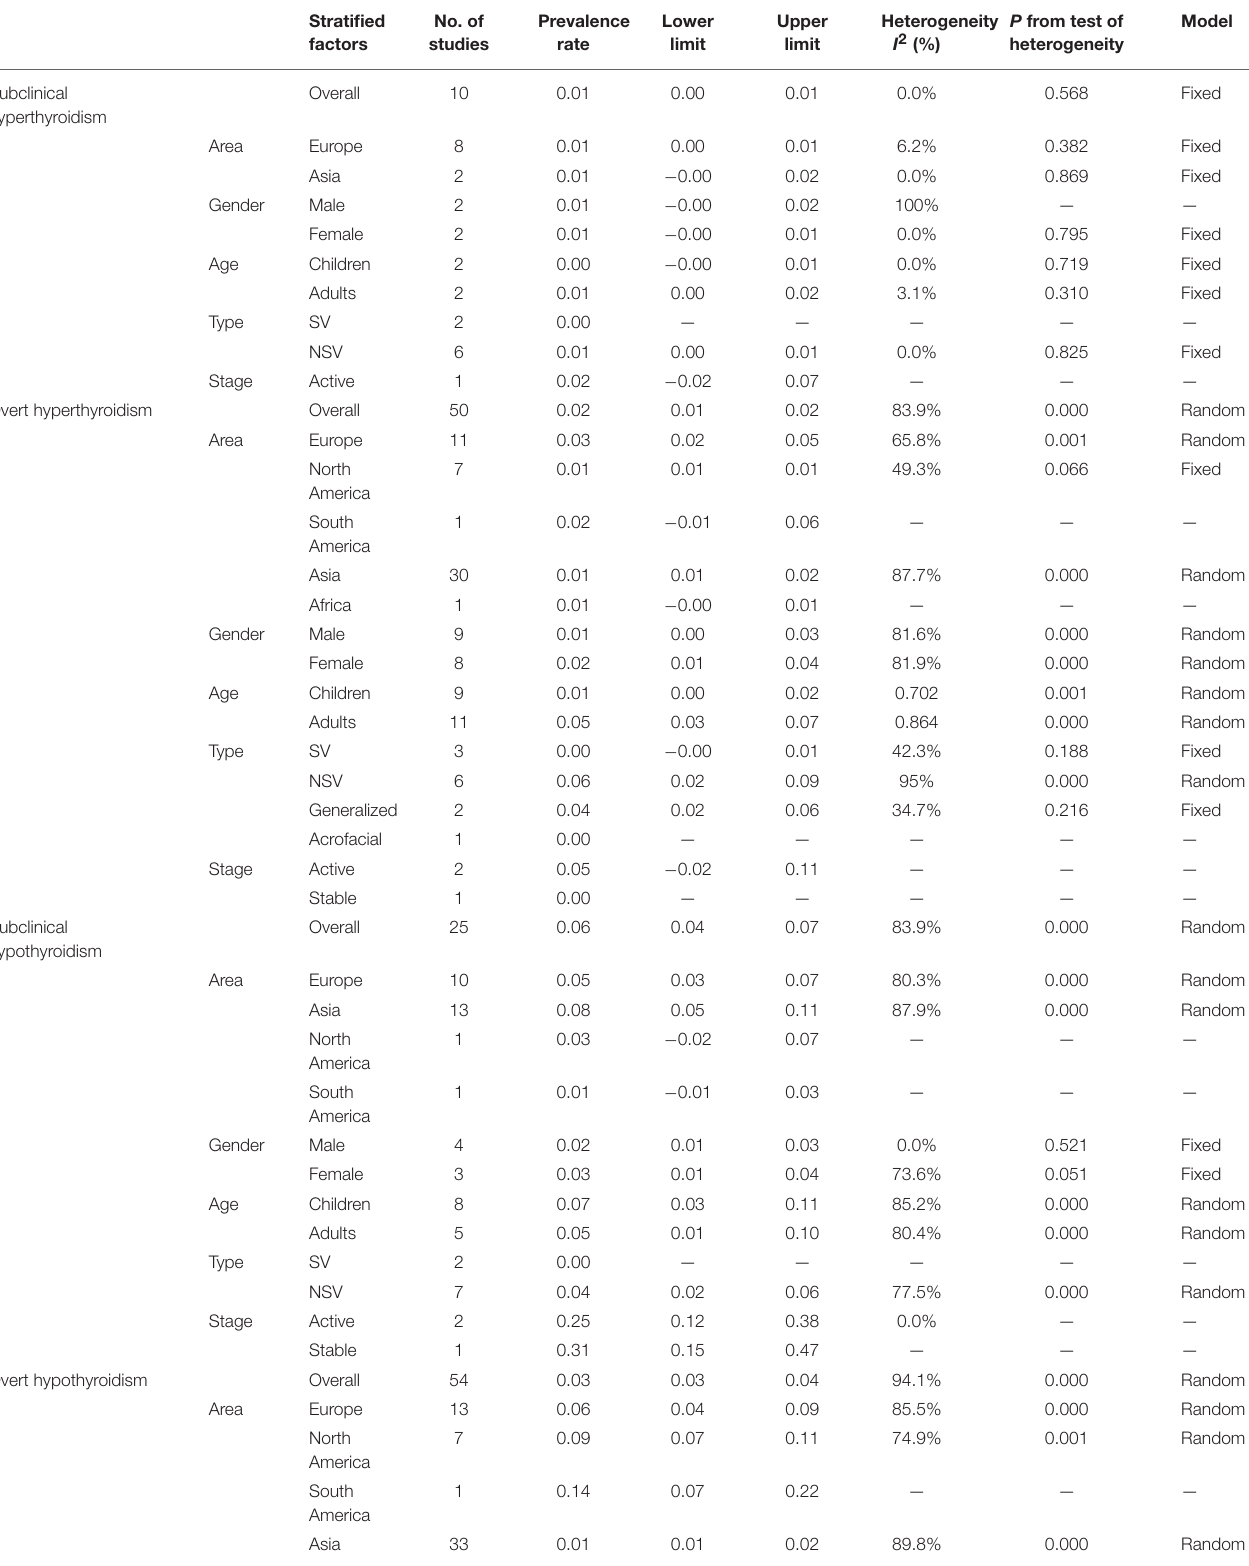
TABLE 2 | The pooled prevalence and subgroup analysis of thyroid disorders in vitiligo